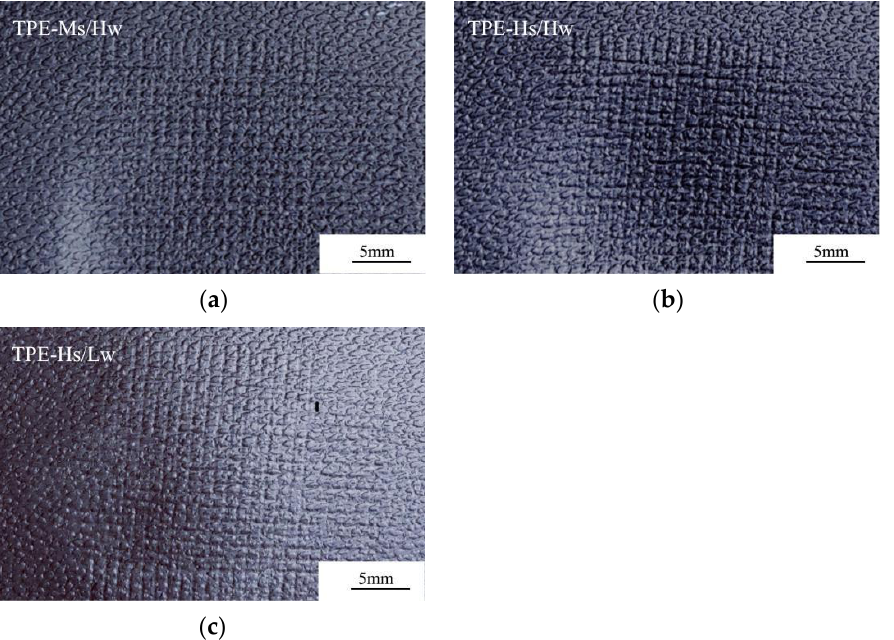
Figure 4. Comparison of TPE cross-scratched samples prepared from SEBS with various styrene